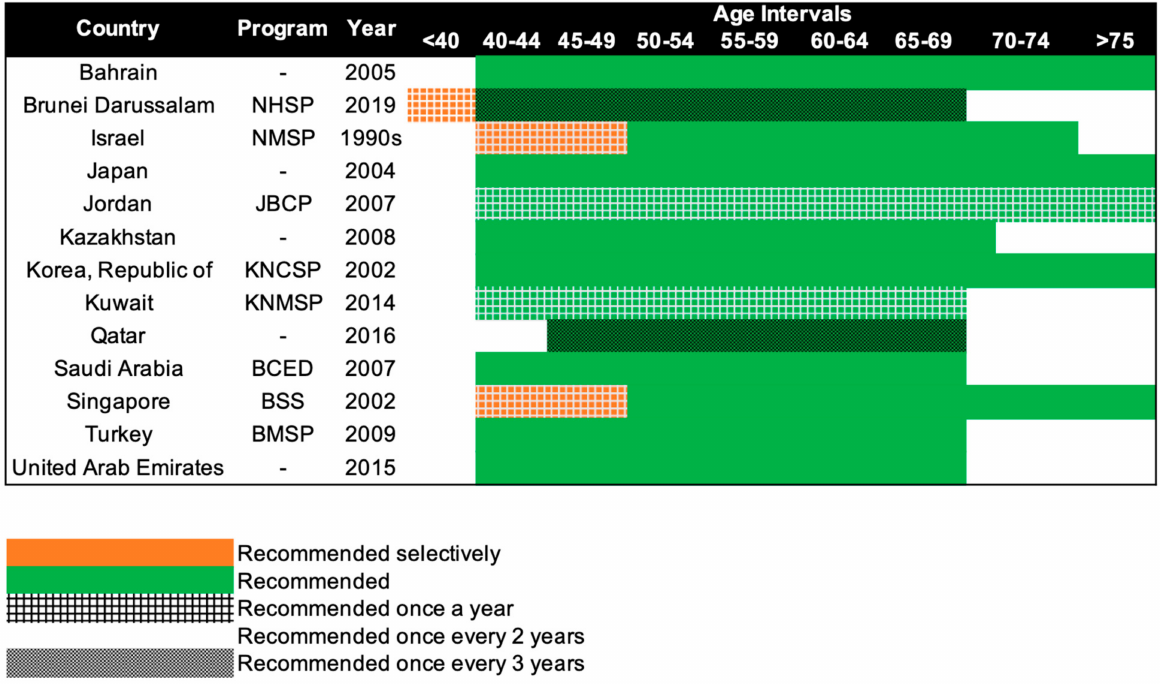
Figure 3. Recommendations of national breast cancer screening programs in Asia. NHSP: National Health Screening Program, NMSP: National Mammography Screening Program, JBCP: Jordan